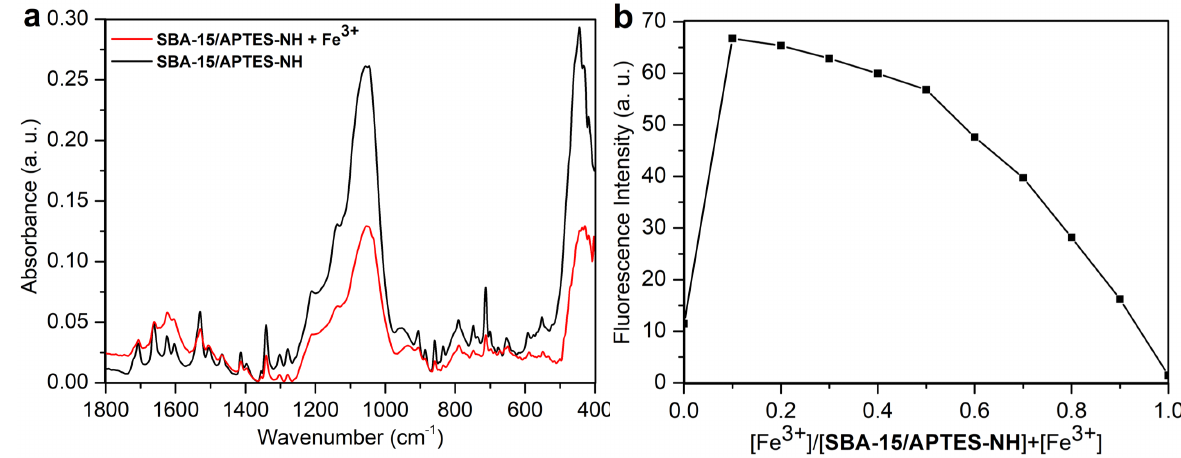
Figure 7: (a) FT-IR spectrum of the SBA-15/APTES-NH with the absence and presence of Fe 3+ ions and (b) Job’s plot for Fe 3+ ions versus nett volume of ligand NH to Fe 3+ ion.